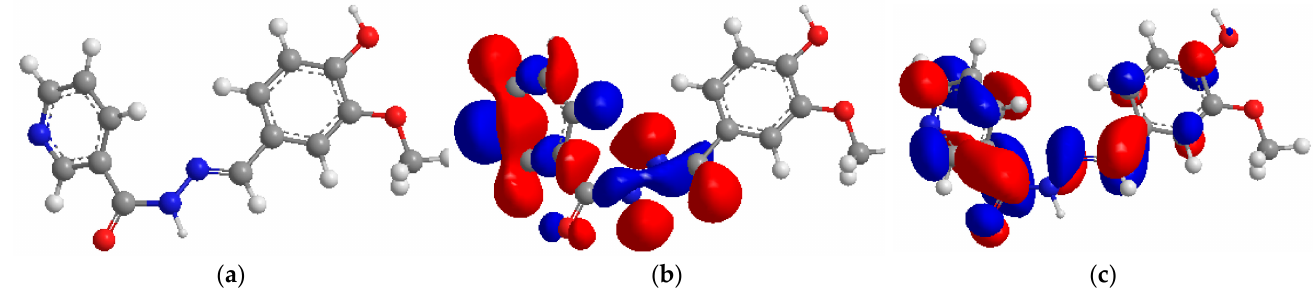
Table 3. Quantum chemical parameters for inhibitors at B3LYP/6-311G (d, p ).